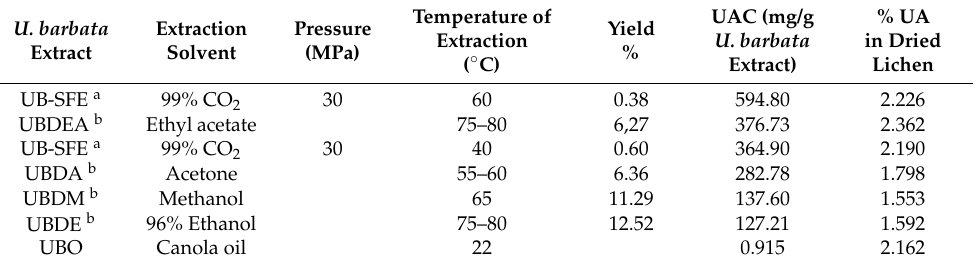
Table 9. Various extraction processes with different conditions correlated with usnic acid content expressed as mg/g extract and % UA in dried U. barbata